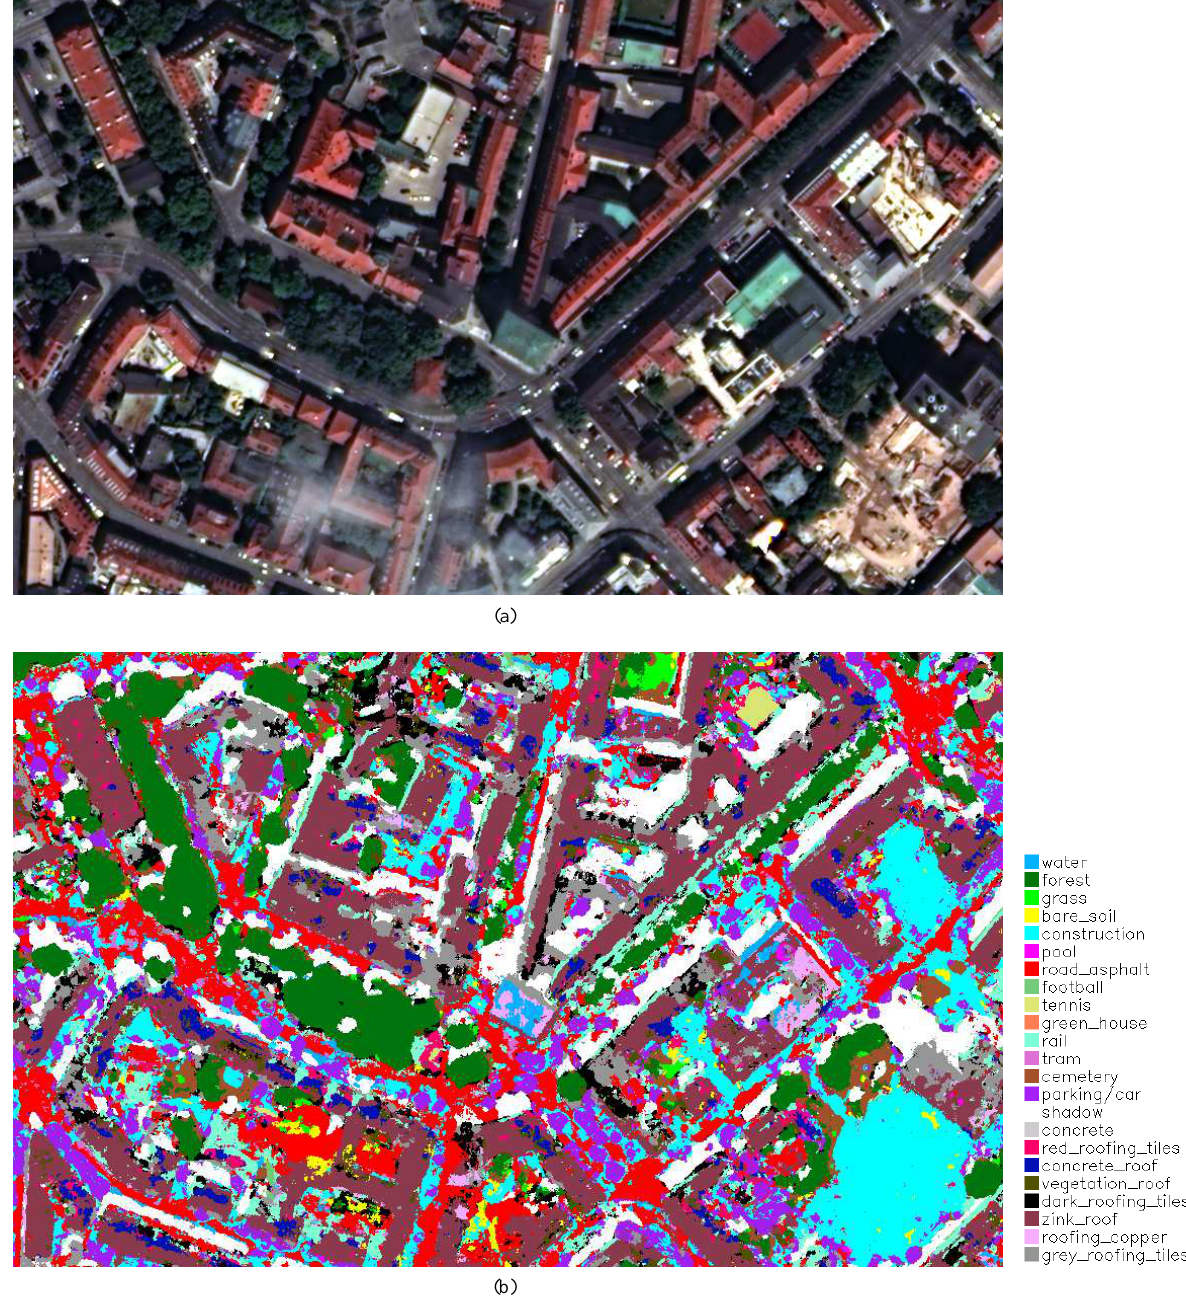
Figure 4: A region of the classification map (INFOFUSE): (a) visible range multispectral image (bands 5,3,2), (b) fusion and classifi- cation by INFOFUSE (this region contains several of the 23 classes) SAR-X, and DSM data allows to obtain approx. 90% of overall accuracy with Kappa equal to approx. 0.89 for 23 classes of in- terest. Fusion of data acquired by a single sensor (e.g. DSM